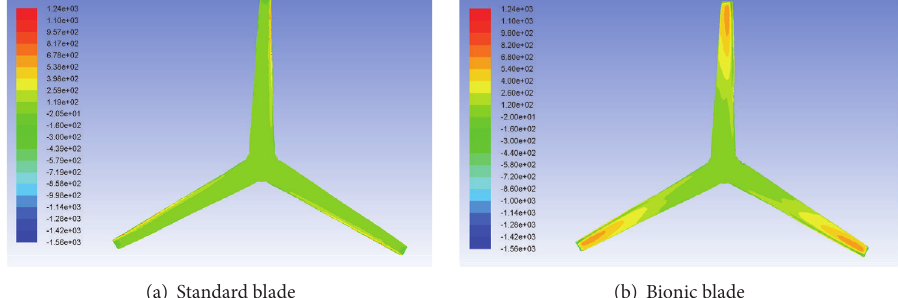
Figure 20: Contours of static pressures on windward surfaces of the